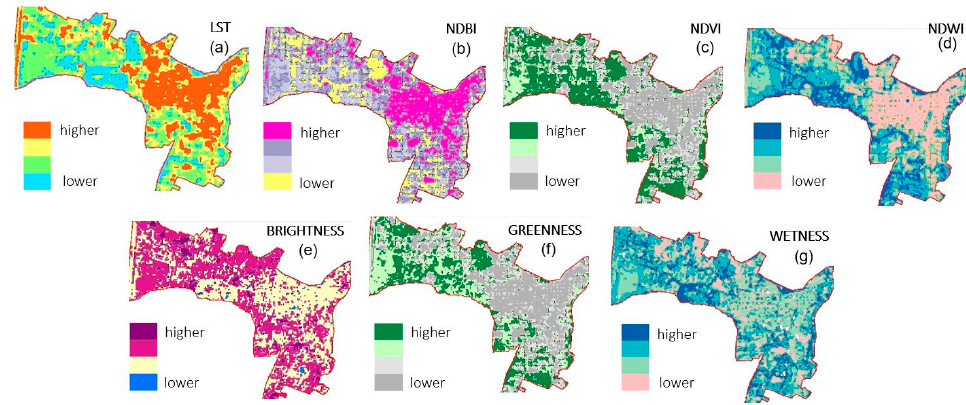
Figure 10. First PCA components for the main factors during the period 2001–2020: ( a ) land surface temperature; ( b ) normalized difference built-up index; ( c ) normalized difference vegetation index; ( d ) normalized difference water index; ( e ) T-cap brightness; ( f ) T-cap greenness; ( g ) T-cap wetness.